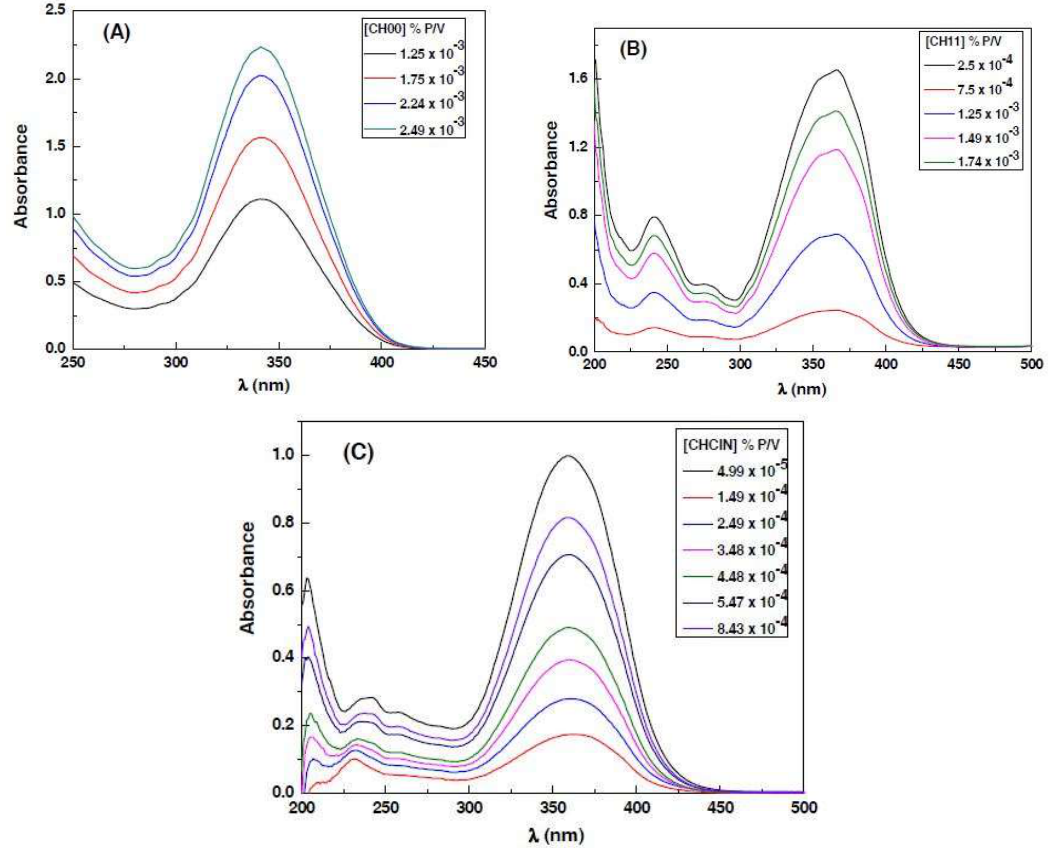
Figure 5. Absorption spectra of chalcones: ( A ) CH00; ( B ) CH11; ( C ) CHCIN.